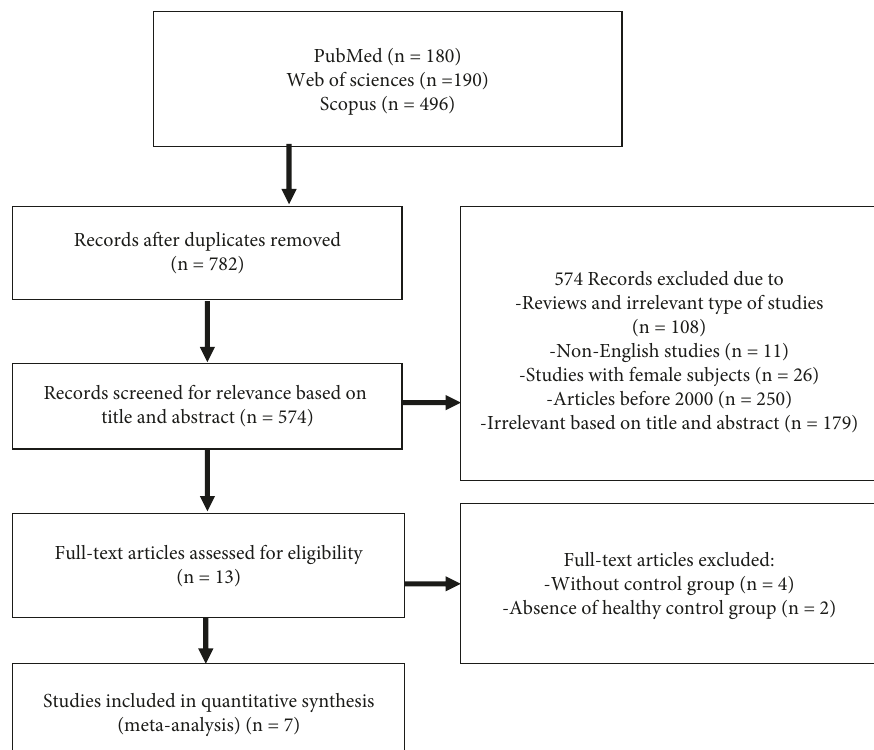
Figure 1: PRISMA flowchart to describe the summaries of included/excluded